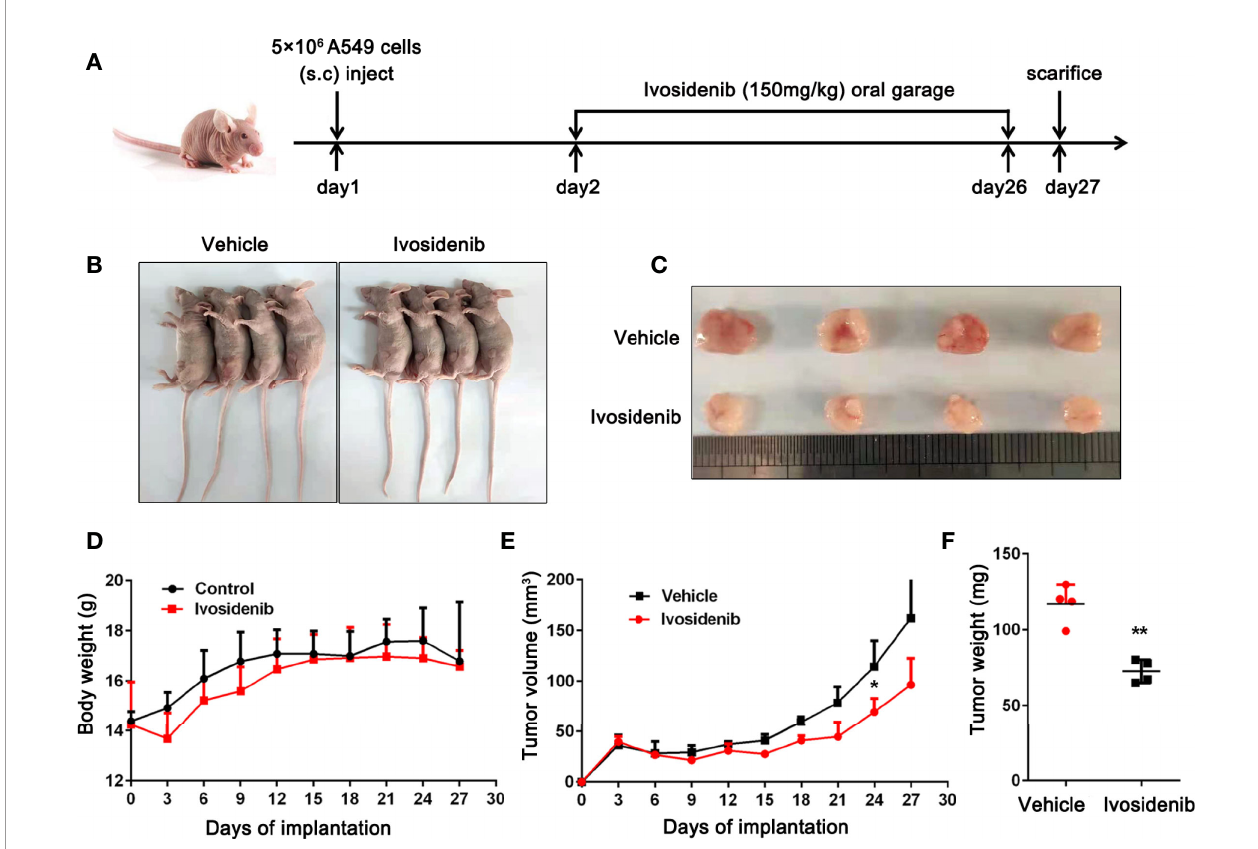
FIGURE 5 | Ivosidenib inhibits the tumor growth in vivo . (A) Diagram of the animal study protocol. (B) Representative images show tumor xenografts. (C) The image and (E) weight of tumor harvested. (F) Tumor volumes and weight were measured, and the volume of the tumor was calculated [(length × width 2 )/2]. (D) Bodyweight calculated every 3 days after implantation. Data are expressed as the mean ± S.D. of fi ve independent experiments. * p < 0.05; ** p < 0.01 vs. the vehicle